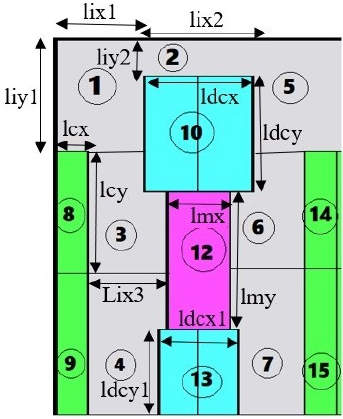
Figure 20. Division of the